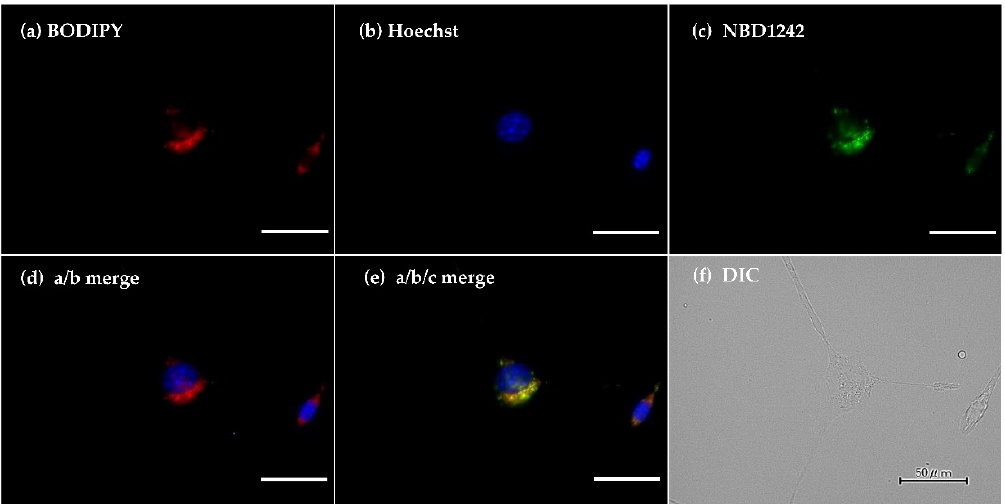
Figure 4. The intracellular distribution of NBD1242 in CT26 colon tumor cells. a (BODIPY), b (DAPI), c (NBD1242), d (merge 4a with 4b), e (merge 4a with 4b and 4c), and f (DIC). Fluorescence microscopy showing intracellular distribution of NBD1242. The scale bar is 50 μm.